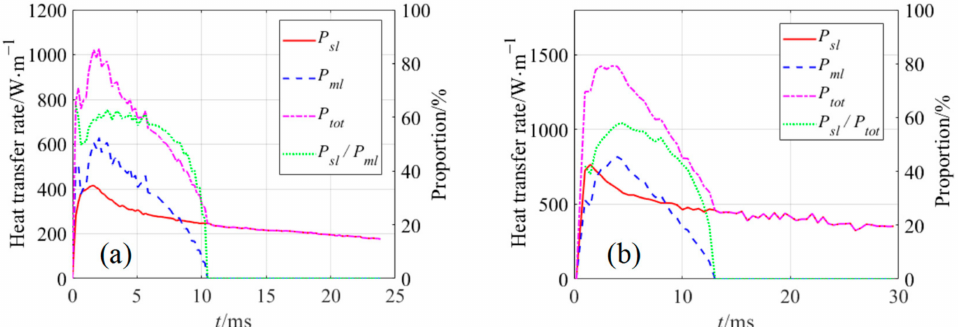
◦ C; ( c ) 100 bilayers LbL ITO heater at ∆ T w = 10.15